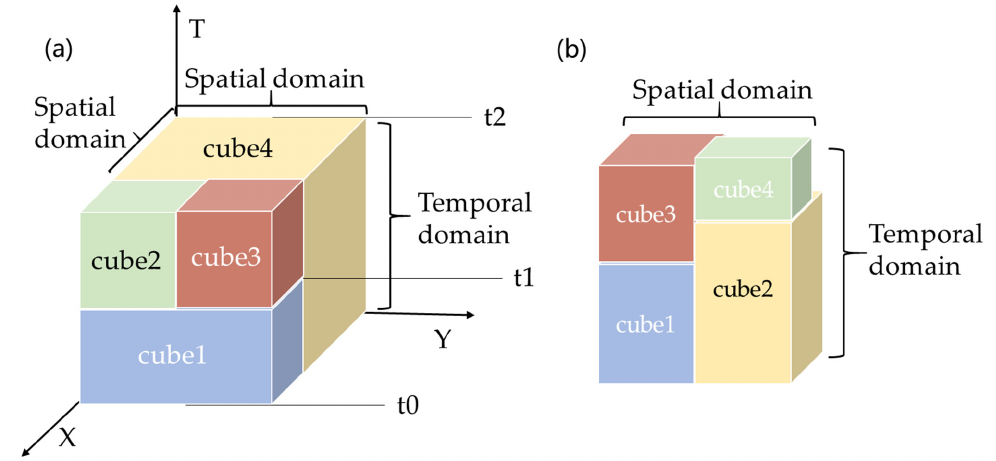
Figure 2. ( a ) Expression of ST-cube. The X and Y axes represent the spatial domain, and the T-axis represents the temporal domain. ( b ) Schematic diagram of spatiotemporal neighborhoods.